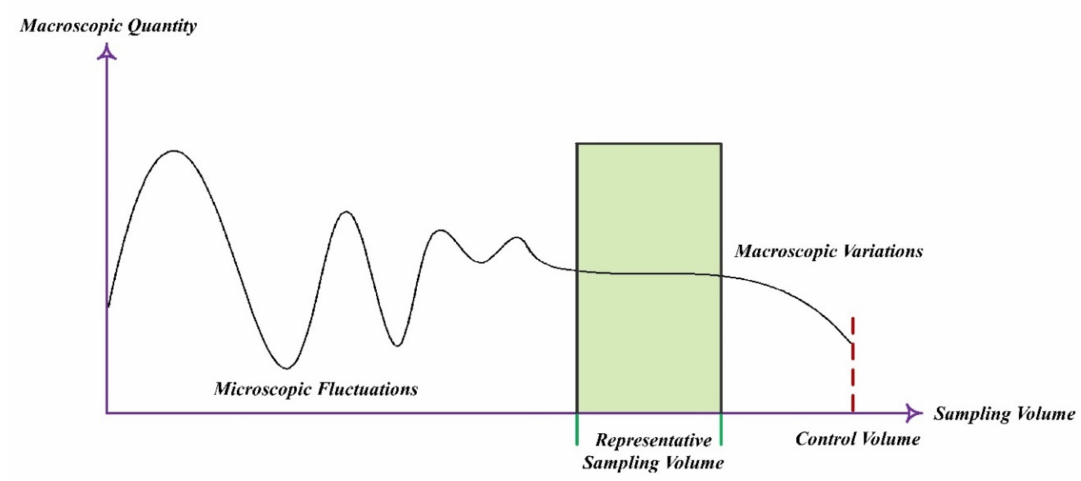
Figure 8. An example of a control volume (shaded area) where a continuum assumption is established. For each control volume comprising thousands of molecules, a set of continuity, momen- tum, and energy equations will be employed. Every single molecule requires the solution of the equations of continuity, momentum, and energy at the microscopic level. With the increasing of the number of equations, computational cost increases so that using CFD methods requires high technology and powerful supercomputers. As shown in Figure 9, although new methods such as LBM have emerged to solve flows at the microscopic level, many disadvantages are still observable [120–126].